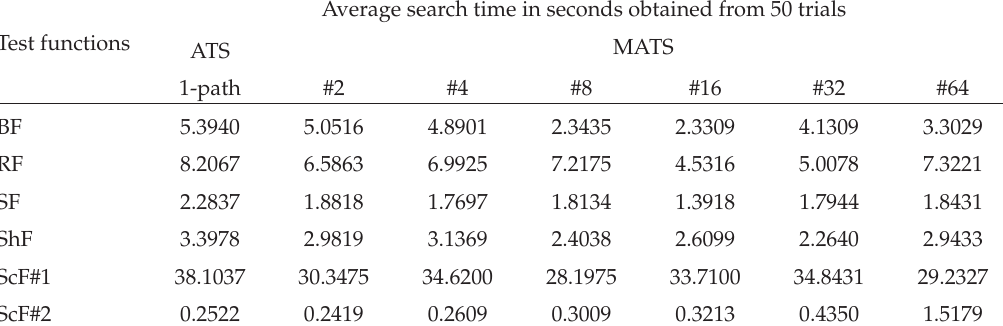
Table 8: Average values of search time in seconds.